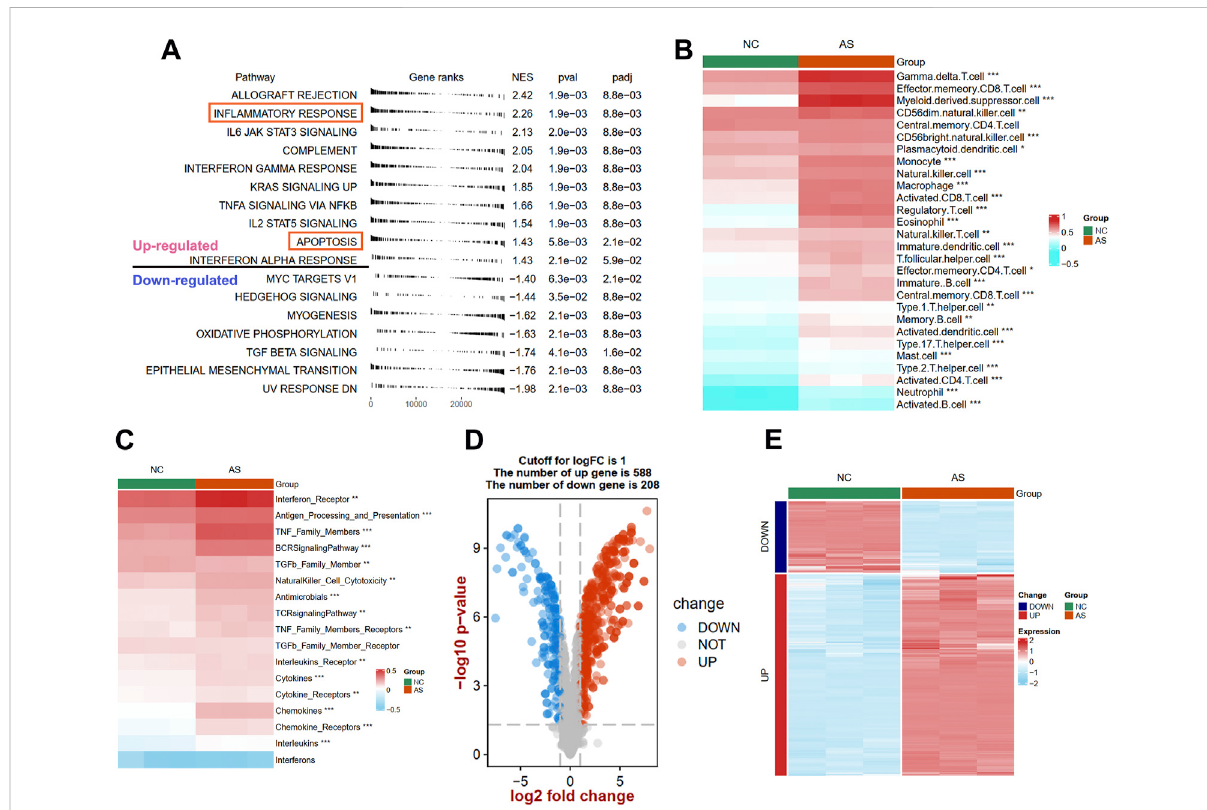
FIGURE 2 Identi fi cation of different function pathways, immune in fi ltration, and DEIRGs in plaque compared with the normal arterial tissues. (A) Up and downregulated hallmark pathways between plaque and controls in GSEA analysis. The difference of immune cell (B) and immune responses (C) between plaque and controls in ssGSEA analysis. A volcano plot (D) and heat map (E) shows the differentially expressed immune-related genes (DEIRGs) between plaque and controls. Signi fi cance level was denoted by * p value < 0.05, ** p value < 0.01, *** p value <